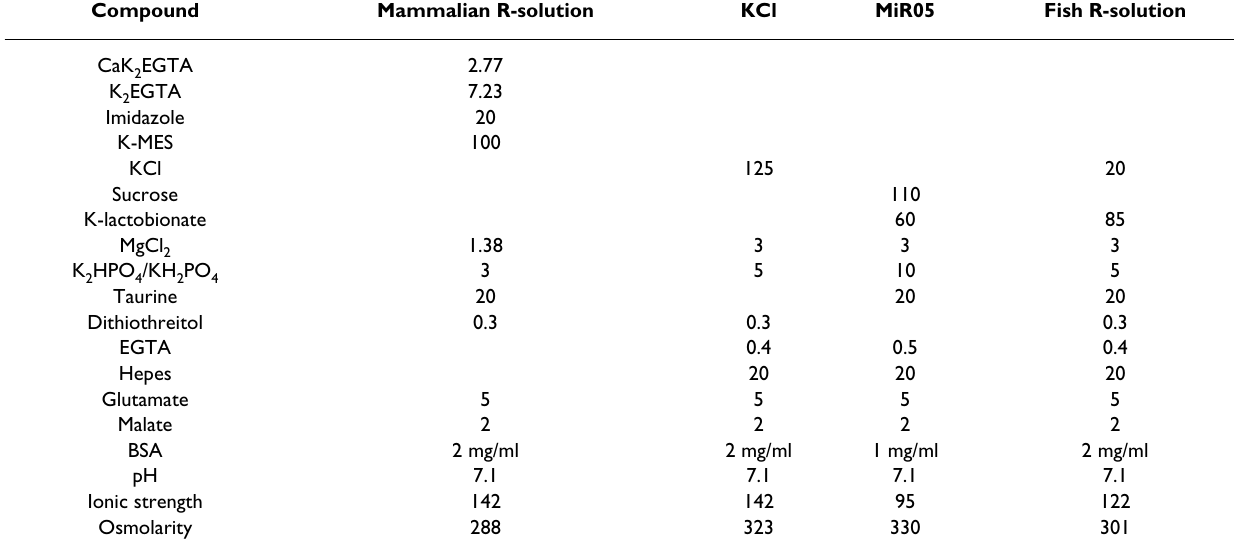
Table 2: Comparison of intracellular solutions Compound